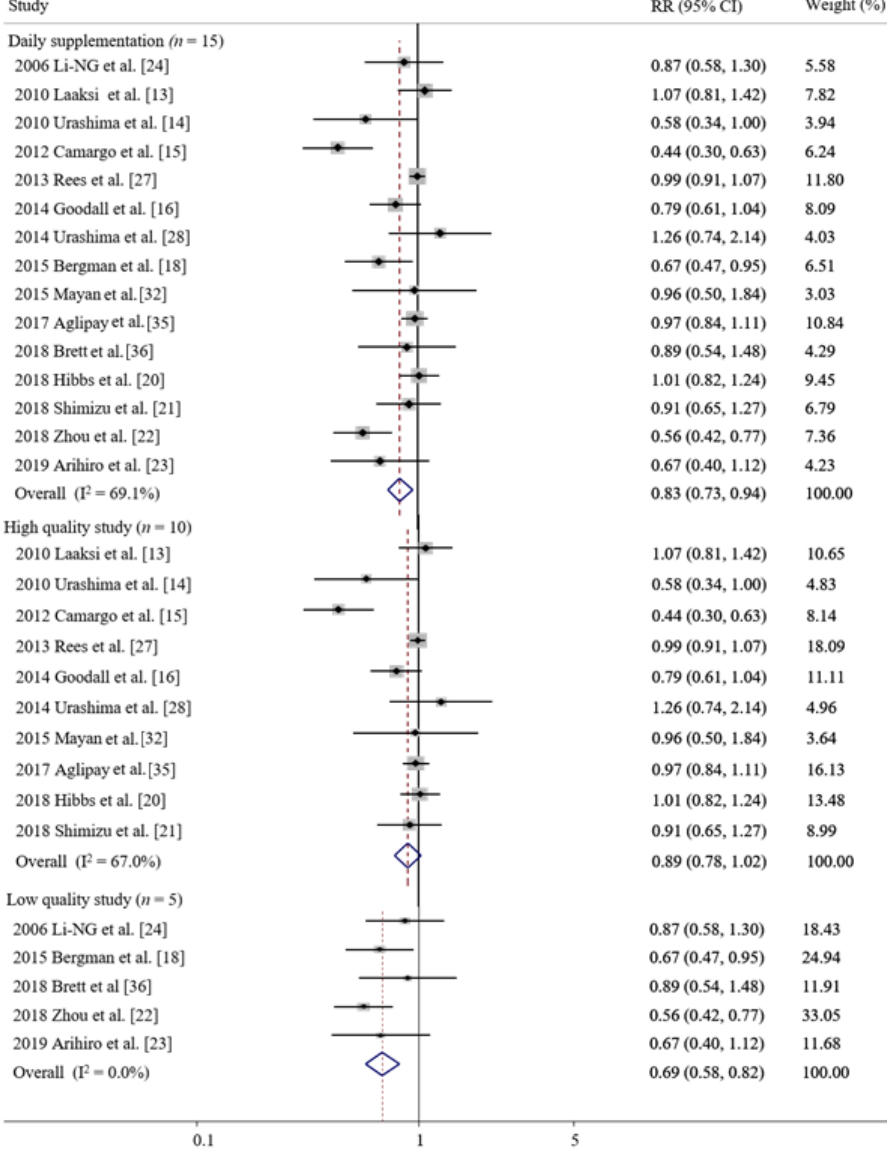
Figure 3. Efficacy of daily supplementation of vitamin D in prevention of acute respiratory infec- tions and its efficacy in subgroup meta-analysis by quality of the study assessed by the Jadad scale [13–16,18,20–24,27,28,32,35,36]. RR, relative risk; CI, confidence interval.